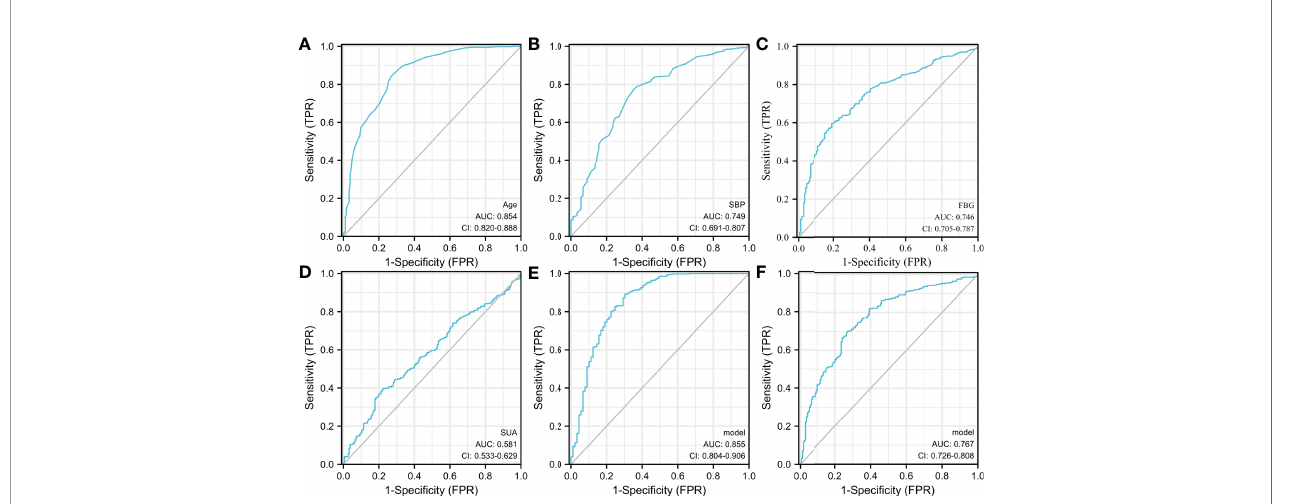
FIGURE 3 | The receiver operating characteristic (ROC) curve. (A – D) Speci fi city of age, SBP, FBG, and SUA for predicting the thickening of CIMT. (E) Speci fi city of SUA combining age, SBP, and FBG for predicting the thickening of CIMT. (F) Speci fi city of SUA combined with FBG for predicting the thickening of CIMT. SUA combined with age, SBP, and FBG had the highest AUC for predicting the thickening of CIMT, followed by SUA combined with